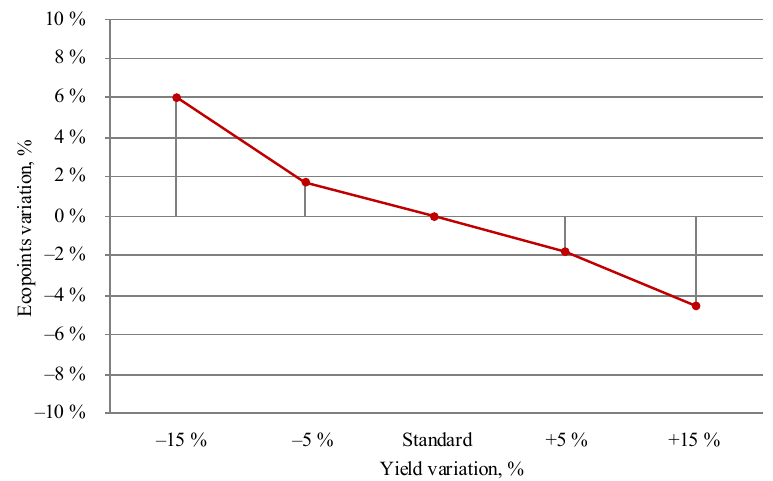
Fig. 6. Sensitivity analysis graph relating to the variation thistle seed